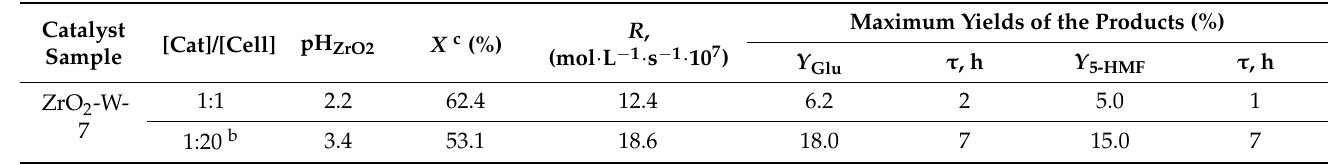
Ar 1 MPa, 1000 rpm, reaction